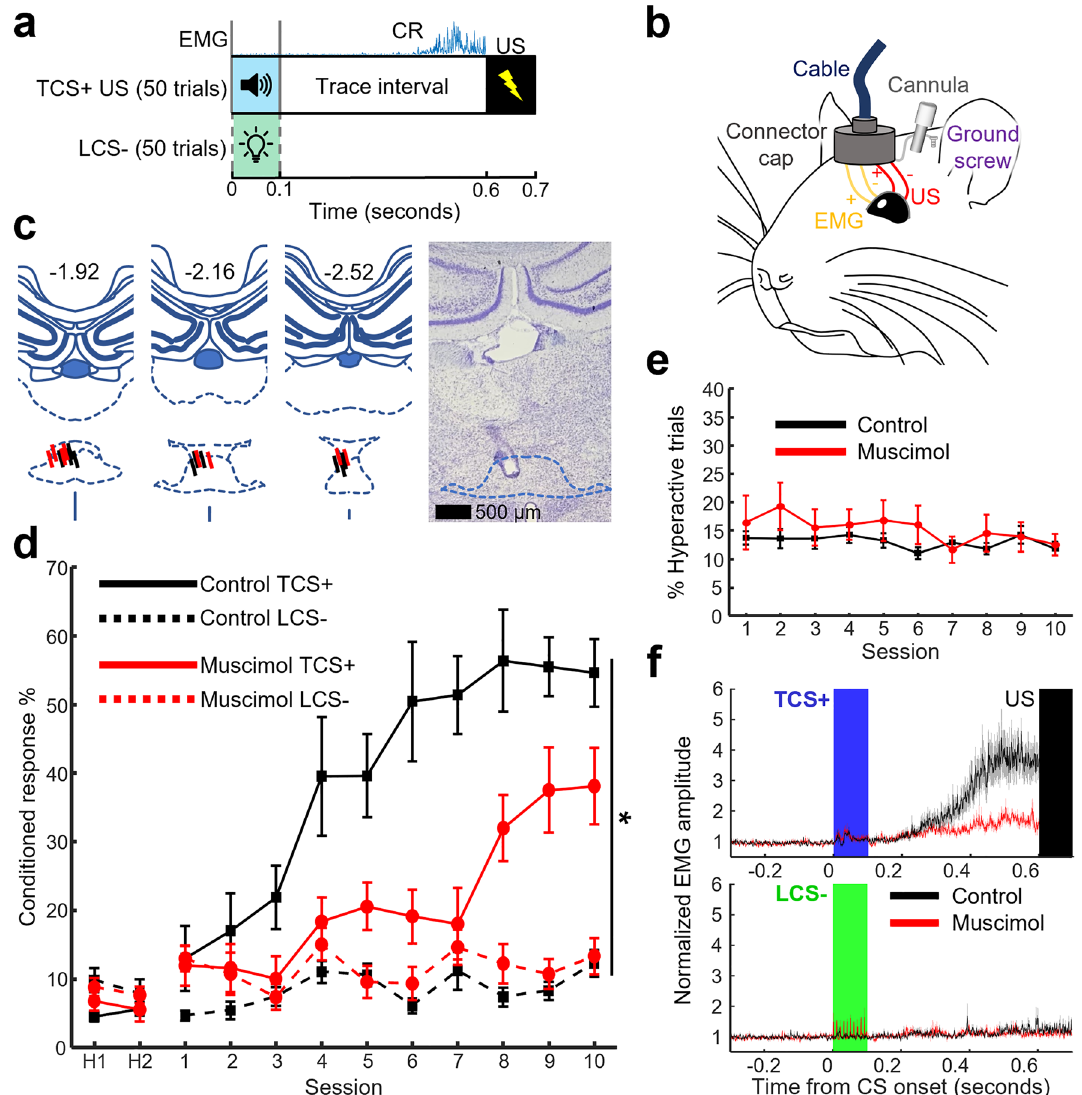
Figure 1. Reversible inactivation of the RE impairs differential associative learning but not stimulus discrimination. ( a ) Behavioral paradigm. The two trial types were randomly intermixed and presented over sessions lasting 50 min. ( b ) Conditioned responses (CR) were detected by recording electromyogram (EMG) activity from the left orbicularis oculi (eyelid) muscle. A microinfusion cannula was implanted targeting the RE. ( c ) Left three: histological reconstruction of cannula tip locations in the RE for all rats included in the final analyses. Black and red bars indicate the infusion cannula position for control (N = 9) and muscimol groups (N = 8), respectively. The numbering at the top indicates the anterior–posterior (AP) coordinates from bregma. Right: representative section in the RE. ( d ) Proportion of trials in which rats expressed the CR to the TCS+ and LCS- (* p < 0.05, Group × CS Type interaction). Error bars indicate ± standard error of the mean (SEM). ( e ) Percentage of hyperactive trials (mean ± SEM). ( f ) Averaged normalized EMG amplitude in session 10. Blue and green rectangles indicate TCS+ and LCS- presentation, respectively. A black rectangle indicates the US presentation. Shaded areas indicate ±